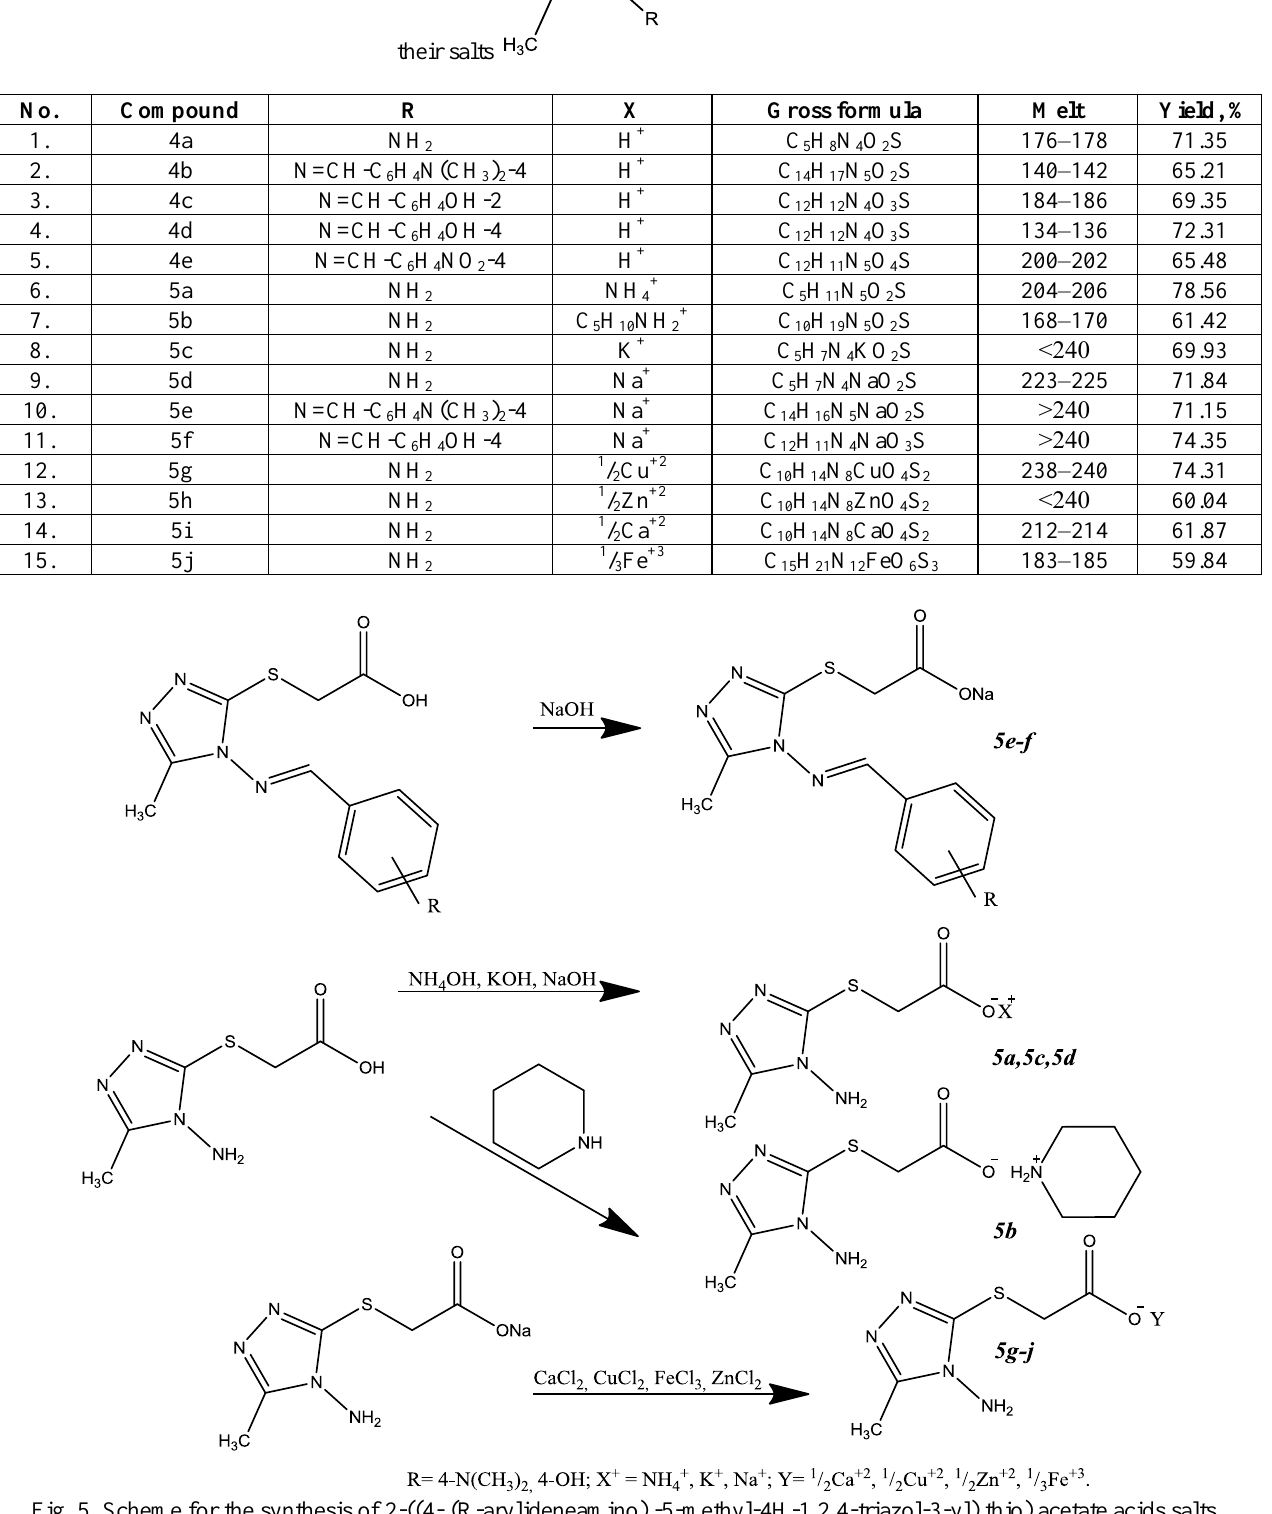
Fig. 5. Scheme for the synthesis of 2-((4- (R-arylideneamino) -5-methyl-4H-1,2,4-triazol-3-yl) thio) acetate acids salts ( 5a-j